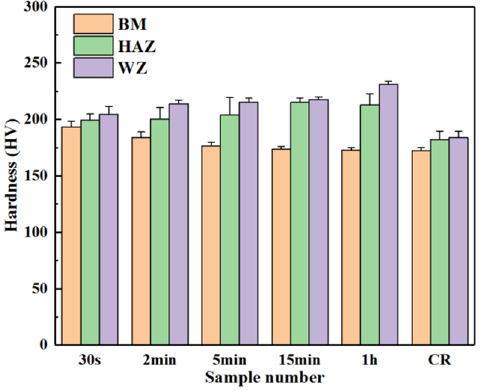
Figure 19. Mean value and error of hardness at different heat treatment time.